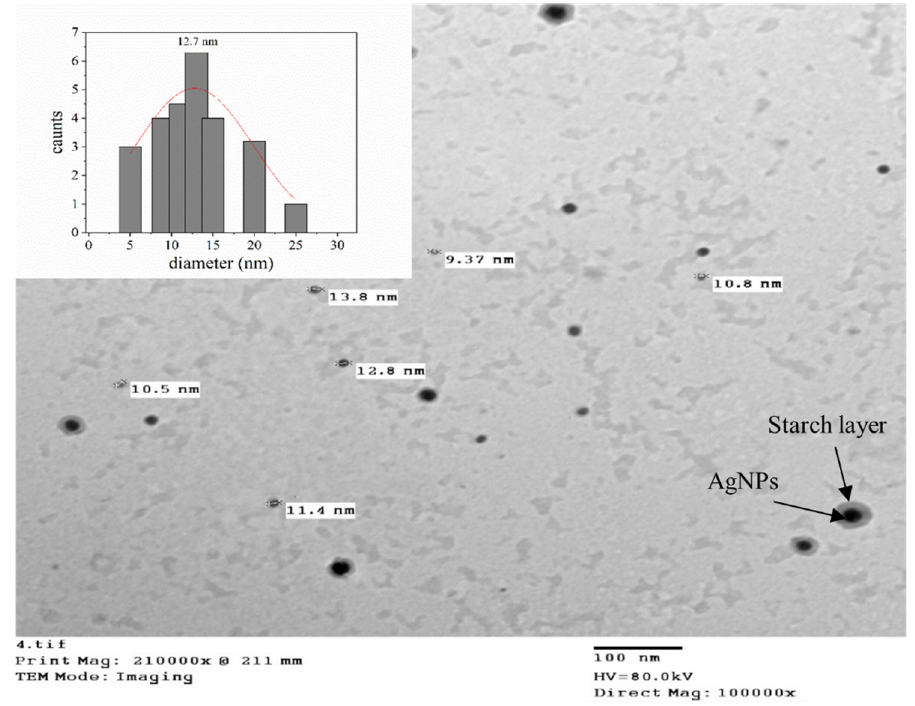
Figure 1. Particle size, shape, and distribution of starch-silver nanoparticles examined using TEM.